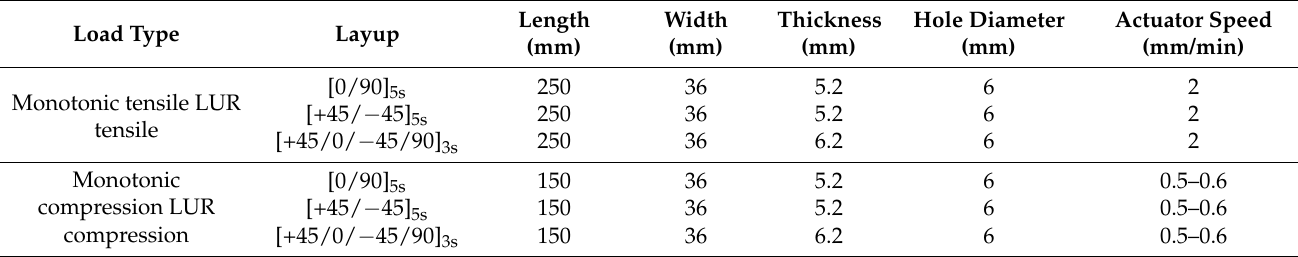
Table 1. Overview of specimens and load